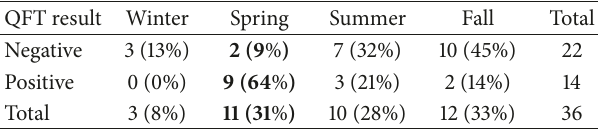
Table 2: QFT test results by